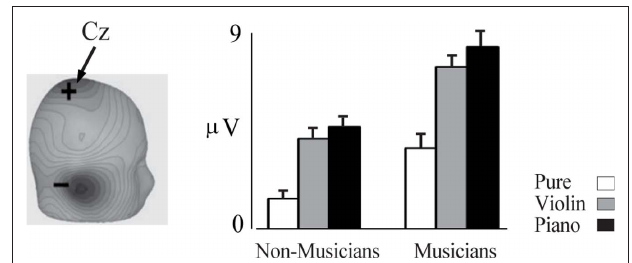
FiGurE 3 | P2 indexes pitch and is enhanced in musicians. Left, scalp current density topography for the P2 component occurring at about 185 ms. Right, amplitude of the P2 response is shown for pure tone in the musicians ( n = 20) and non-musicians ( n = 14). The error bars depict 1 SE. Based on data from Shahin et